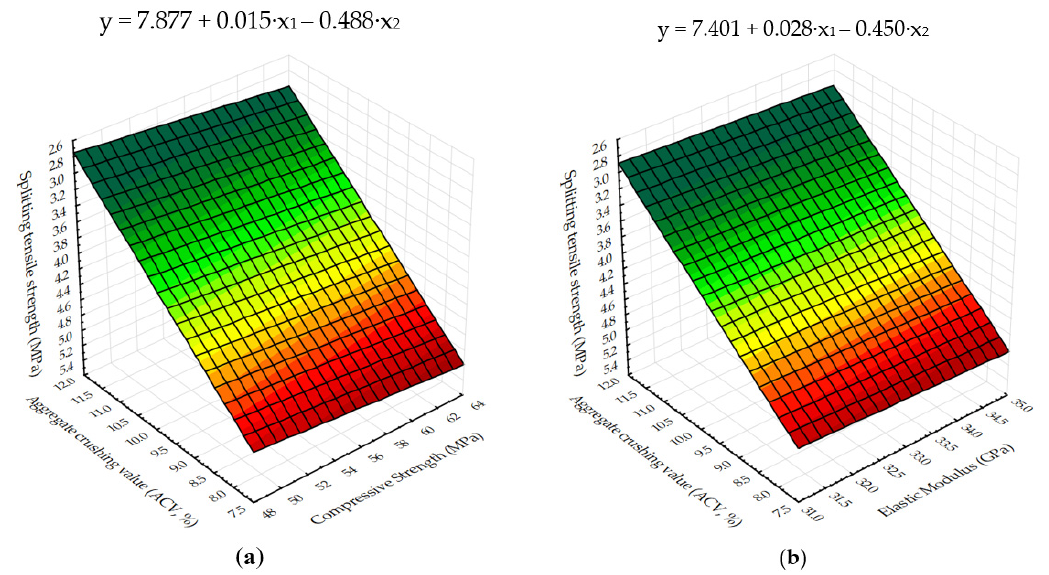
Figure 6. Three-dimensional surface plot: ( a ) the splitting tensile strength (MPa) against the compressive strength (MPa) and the aggregate crushing value (ACV), ( b ) the splitting tensile strength (MPa) against the elastic modulus (GPa) and the aggregate crushing value (ACV).